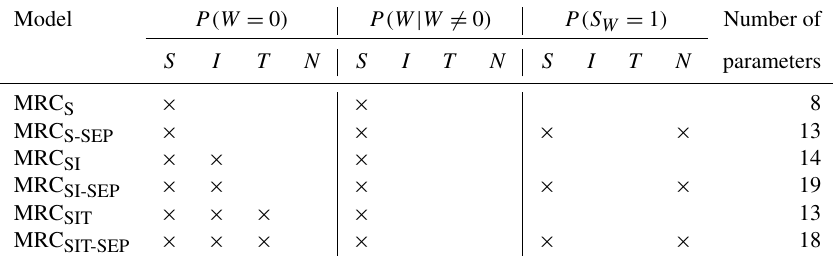
Table 2. Nomenclature of the models and various quantities taken into account by each model depending on the process considered; S is the timescale, D the rainfall depth/intensity, T the temperature and N the close